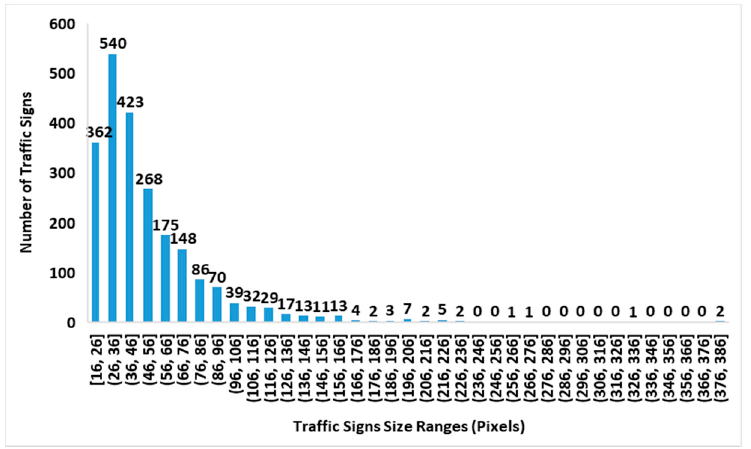
Figure 13. A histogram of the traffic sign size distribution in the German traffic sign detection benchmark (GTSDB). Sensors 2019 , 19 , x FOR PEER REVIEW